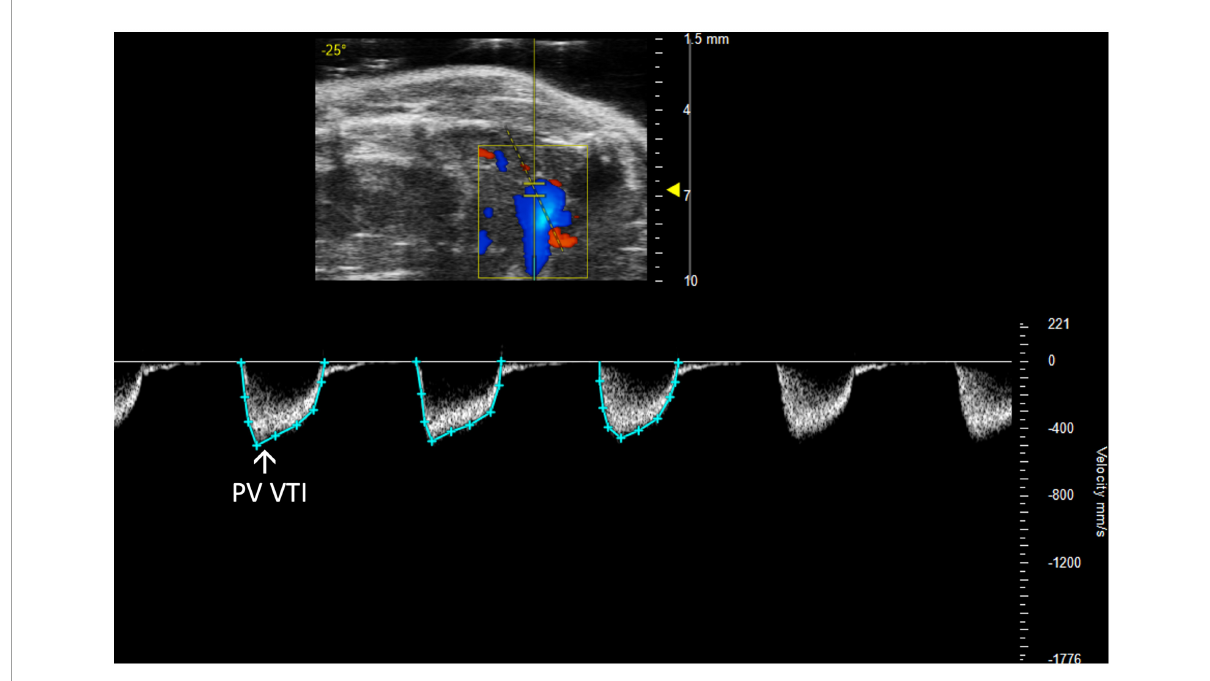
FIGURE5 The pulmonary valve velocity time integral (PV VTI), a measure of blood flow through the pulmonary valve, is calculated by measuring the area under the curve in pulsed wave (PW) Doppler mode of the parasternal long axis view (PLAX).